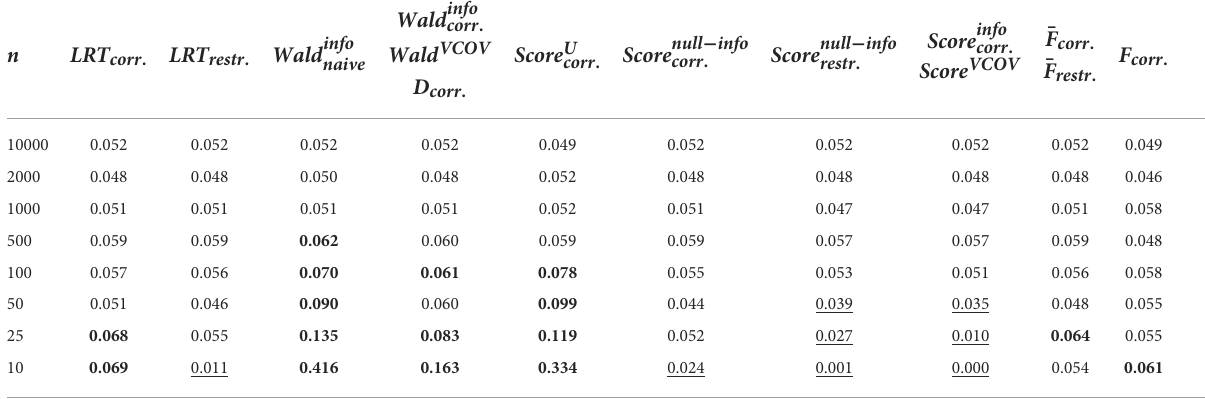
TABLE 4 Type I error rates when using R 2 and applying the test statistics as outlined in the referenced books.